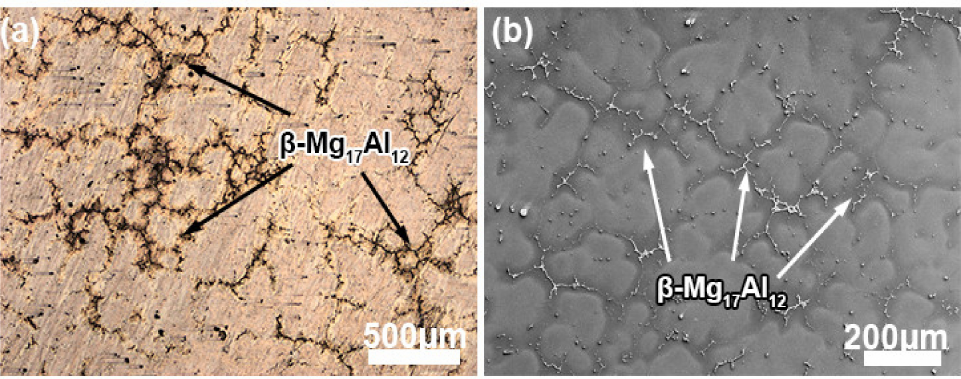
Figure 2. The ( a ) OM and ( b ) SEM images of the as-homogenized AZ80